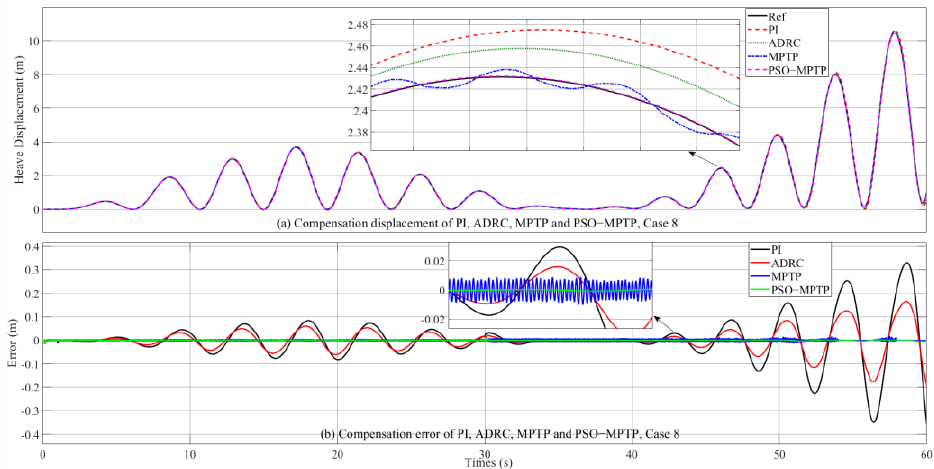
Figure 17. ( a ) Compensation displacement of PI, ADRC, MPTP, and PSO − MPTP, Case 8. ( b ) Com- pensation error of PI, ADRC, MPTP, and PSO − MPTP, Case 8.